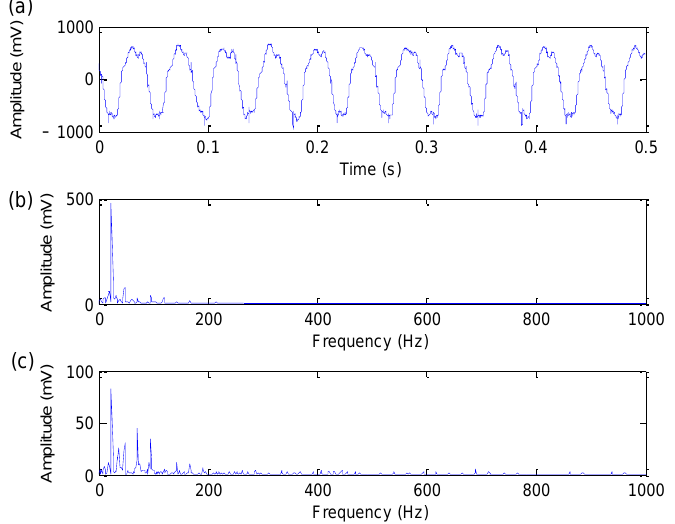
Figure 14. Bearing inner race fault signal: ( a ) Time domain waveform; ( b ) amplitude spectrum; ( c ) envelope spectrum.